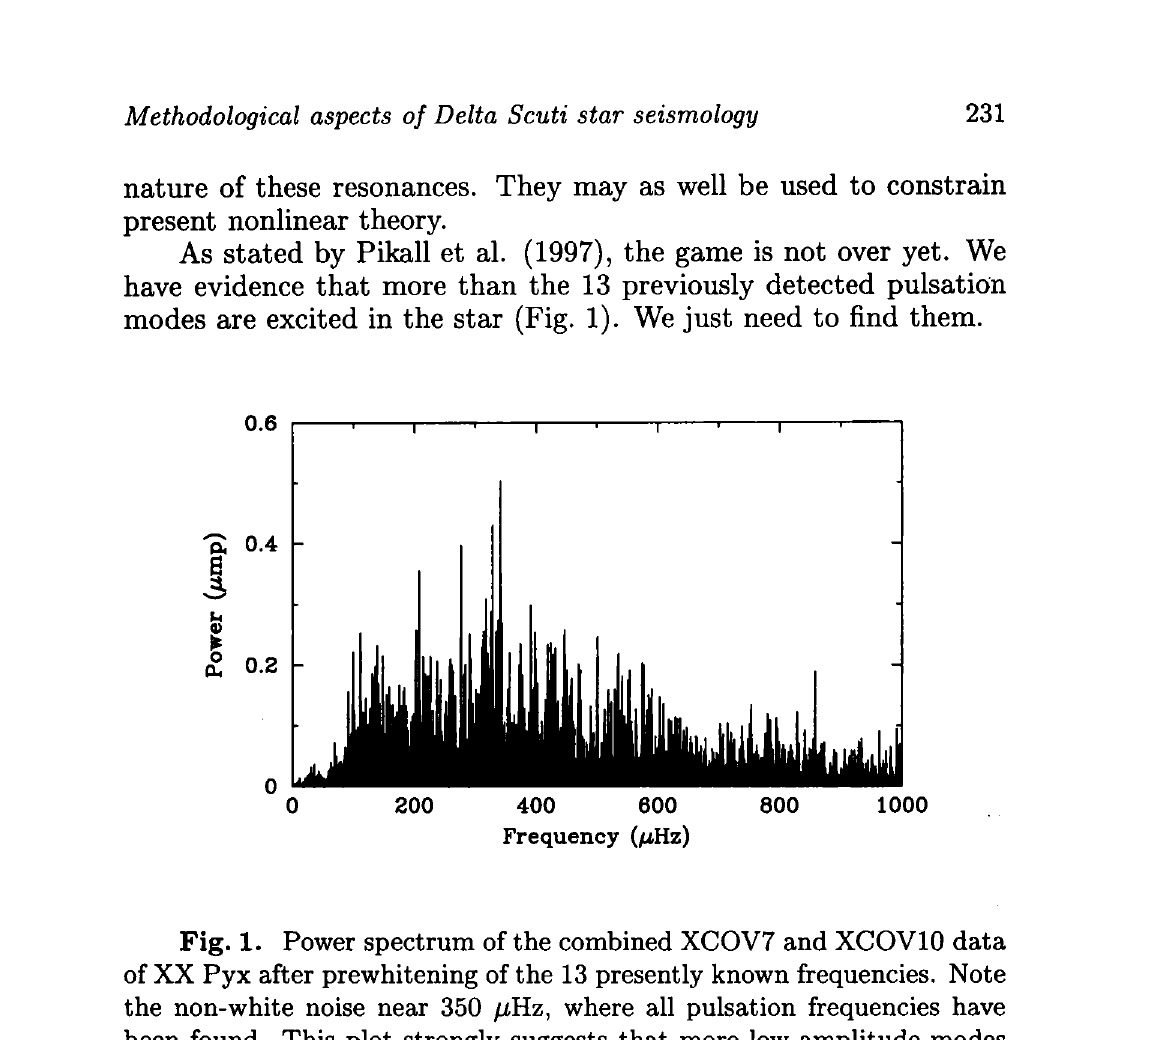
Fig. 1. Power spectrum of the combined XCOV7 and XCOVIO data of XX Pyx after prewhitening of the 13 presently known frequencies. Note the non-white noise near 350 μΗζ, where all pulsation frequencies have been found. This plot strongly suggests that more low-amplitude modes are excited in the star. Note also the increase in "noise" near 800 μΗζ. It is due to further linear combination